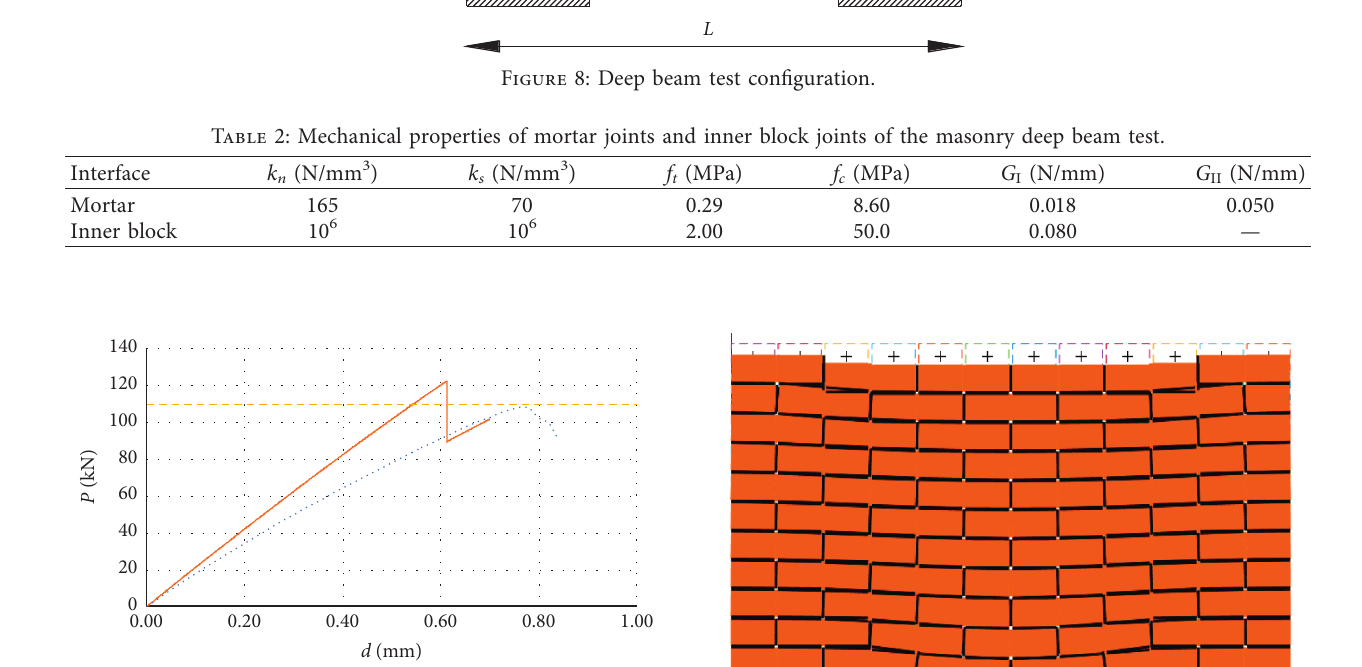
Figure 9: Pushover curves of the numerical masonry deep beam tests. Continuous line for refined rigid block model, dotted line for FE-TSRCM, and dashed line for laboratory test results.